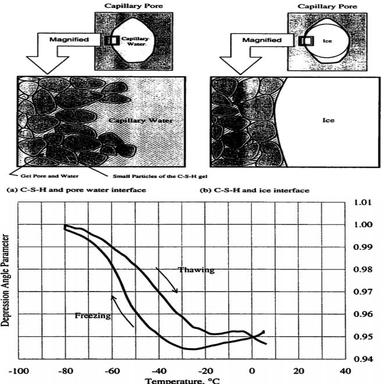
(up): Illustration of the "C-S-H gel interface" of capillary pores (below): the depression angle parameter versus temperature for a cement paste specimen subjected to the freeze-thaw cycle.